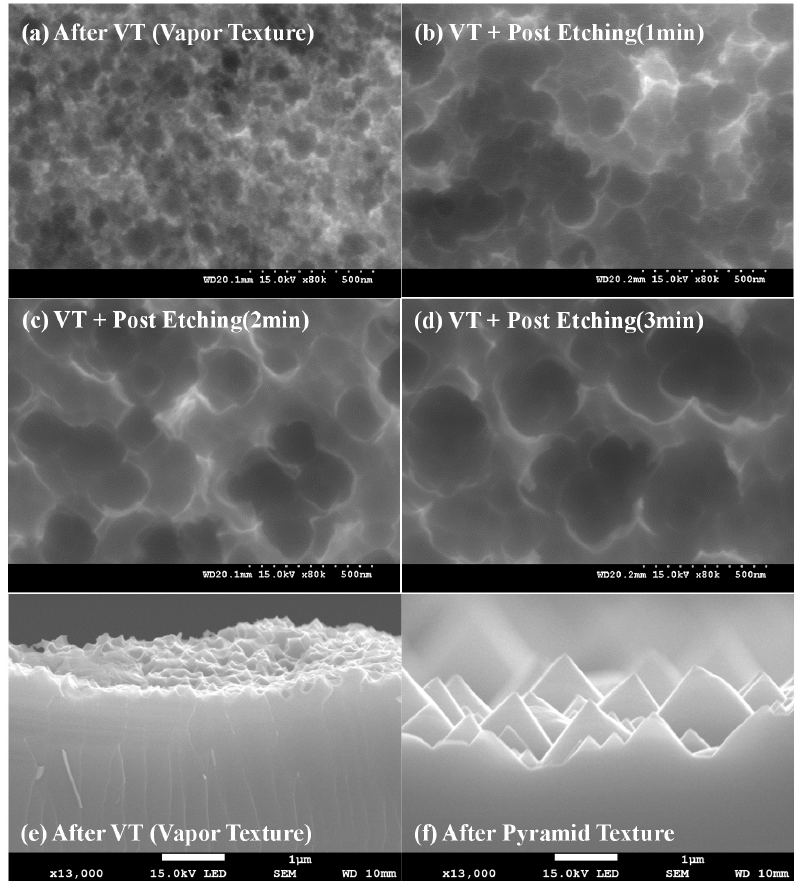
Figure 2. Changes in surface morphology according to nanostructure of vapor texture ( a ) and after post-etching for 1 ( b ), 2 ( c ), and 3 min ( d ); cross-section of nanostructure from the vapored-texture process ( e ); cross-section of micro-pyramid structure from the pyramid textured process ( f ).